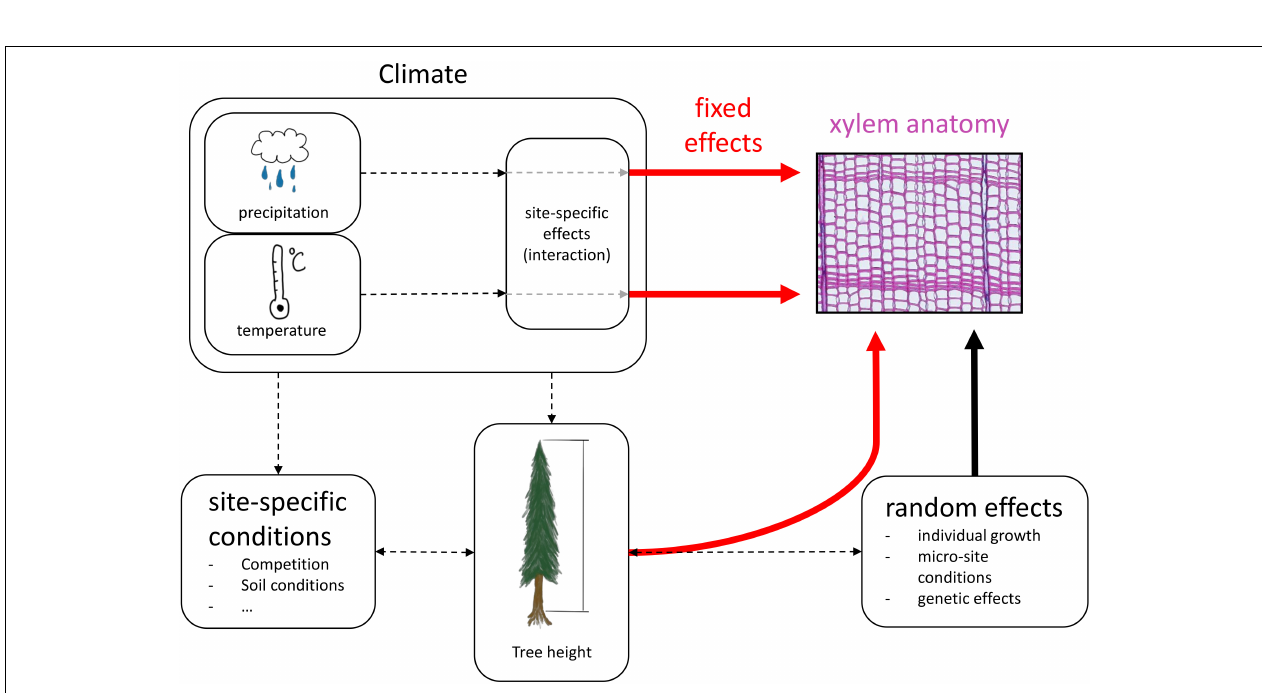
FIGURE 3 | Conceptual design of the linear mixed-effects model. Red arrows indicate fixed effects, the black arrow indicates random effects and black dashed arrows show interactions and effects that are not quantified in the models.